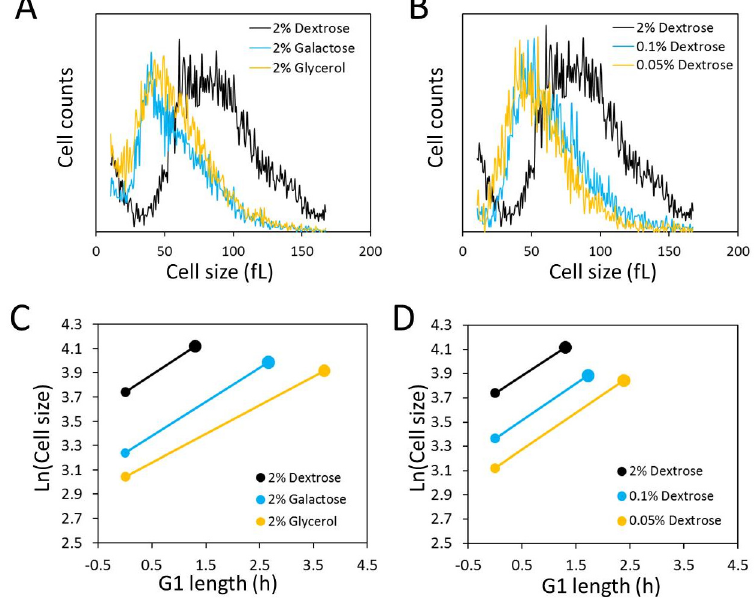
FIGURE 1. Nutrient control of size homeostasis and rate of size increase. (A) and (B) Cell size histograms of exponentially and asynchronously proliferating wild type diploid cells (strain BY4743), cultured in 1% w / v yeast extract, 2% w / v peptone and the indicated amount of the car- bon source shown. The x-axis is cell size and on the y-axis is the number of cells. (C) and (D) Graphical representation of G1 variables in the growth conditions shown in A and B, using the values shown in Table 1. The x-axis is the calcu- lated length of the G1 phase and the y-axis is the natural log of cell size at birth. The birth size at each condition is indicated with the smaller filled circle and the critical size with the larger filled circle. The length of the line connecting birth size with critical size is equal to the length of the G1 phase (T G1 in Table 1), and the slope of the line is equal to the specific rate of size increase ( k in Table